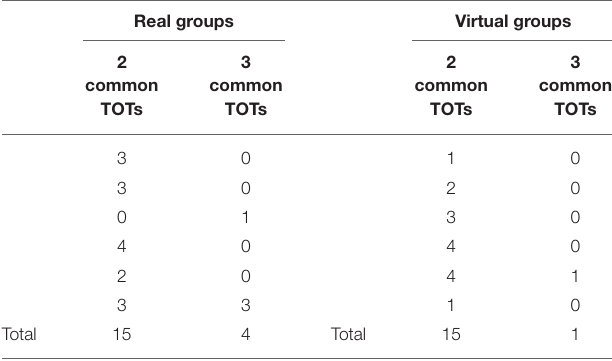
TABLE 7 | Frequency of common positive TOTs in the six real groups (group recall condition), as well as in the six virtual groups (each composed of four participants from different real